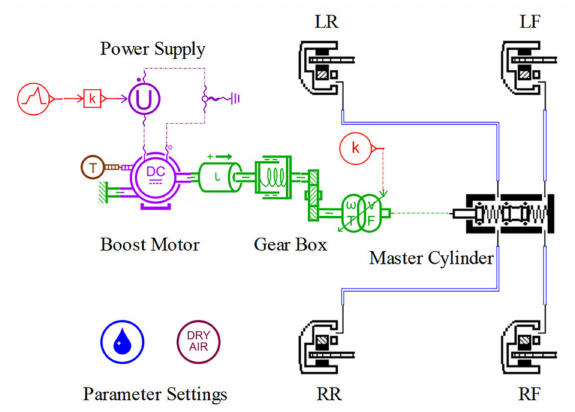
Figure 6. Dynamic model of the EBMC in